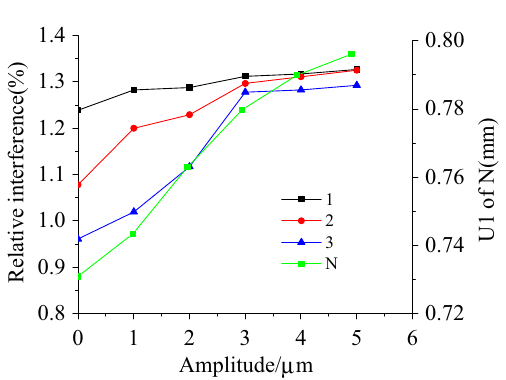
Figure 16. The displacement of node N in x-axis and the relative interference of node 1, 2 and 3 vary with the